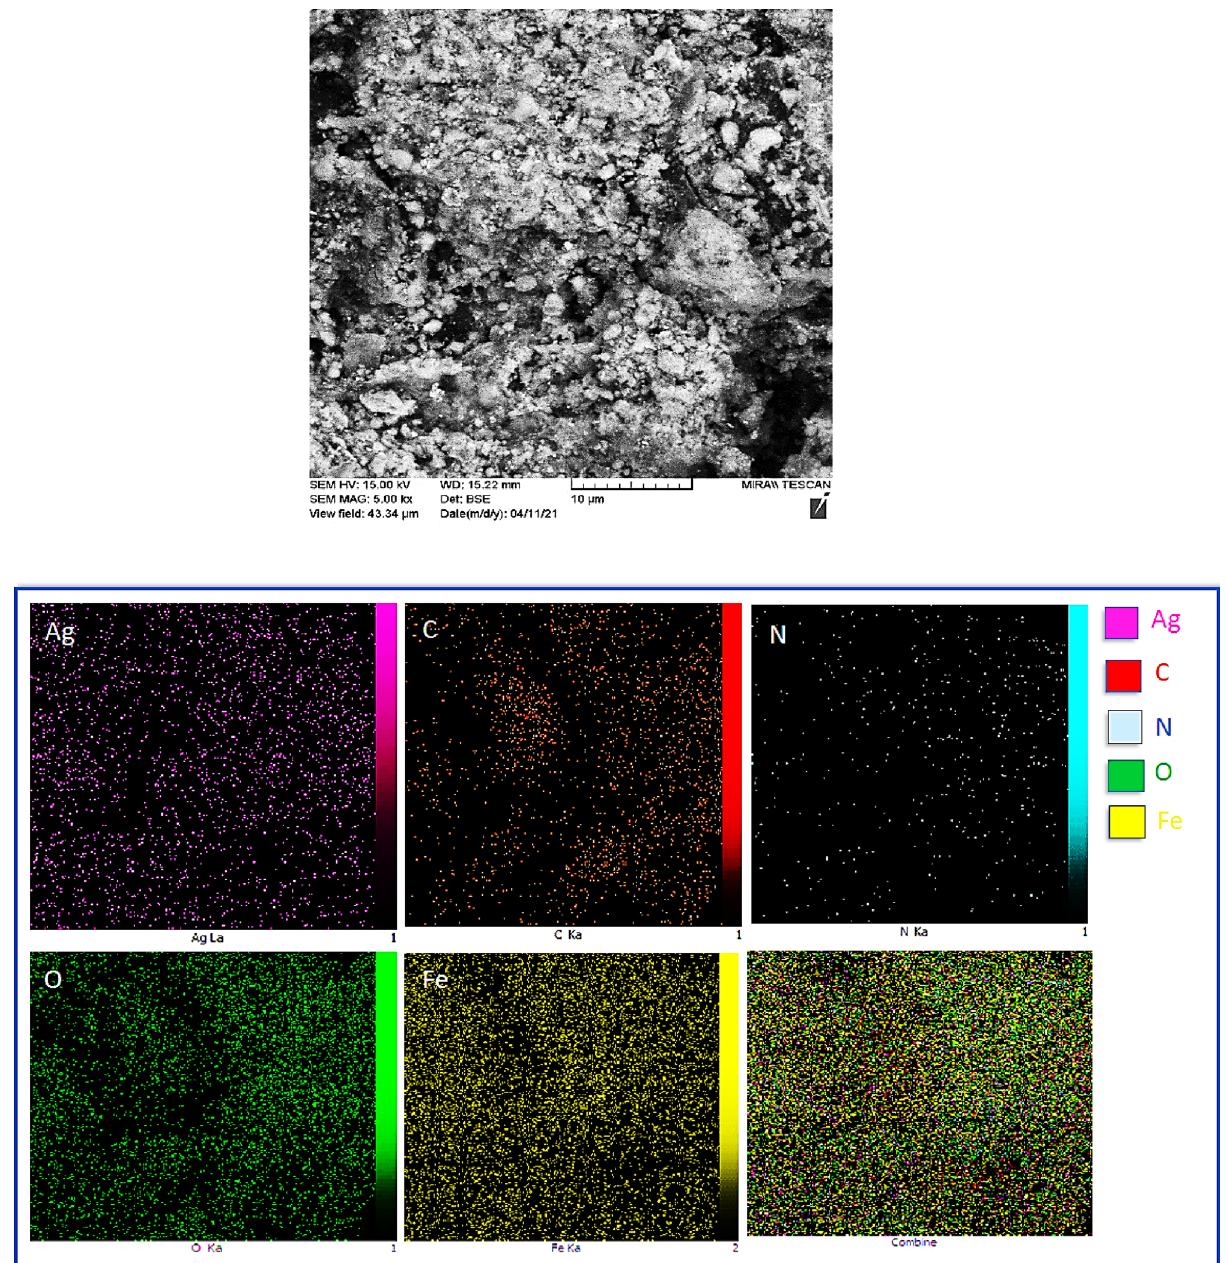
Figure 6. Elemental mapping of biochar/Fe 3 O 4 /PVIm/Ag